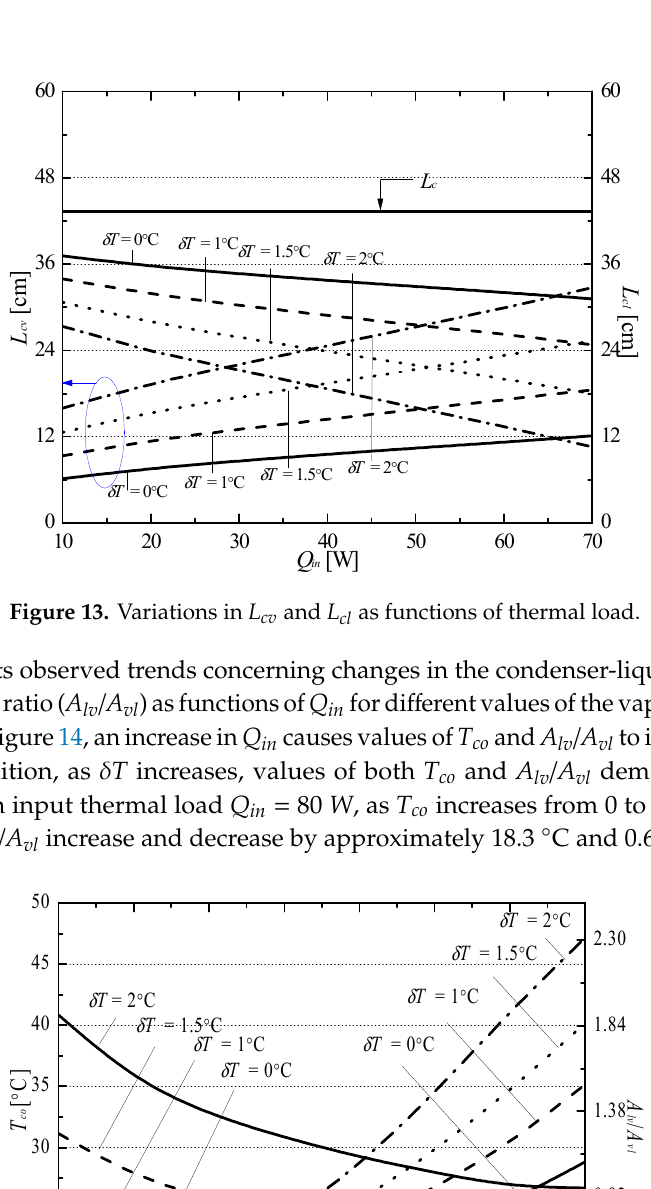
Figure 12. Variations in T lv and T vl with input thermal load for different porosities.